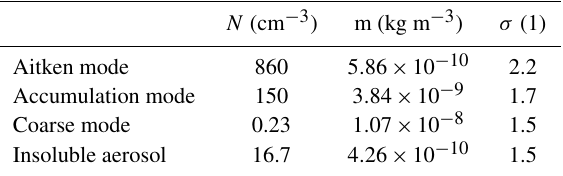
Table 1. Parameters of the aerosol size distribution in the boundary layer prescribed in the initial and lateral boundary